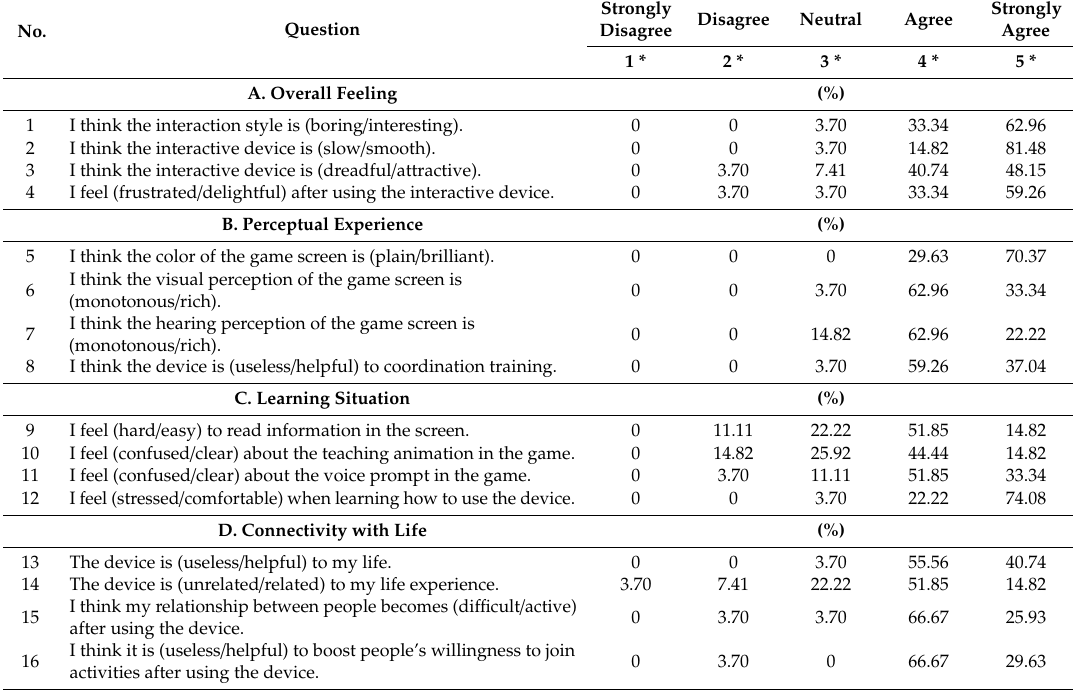
The device is (useless / helpful) to my life.